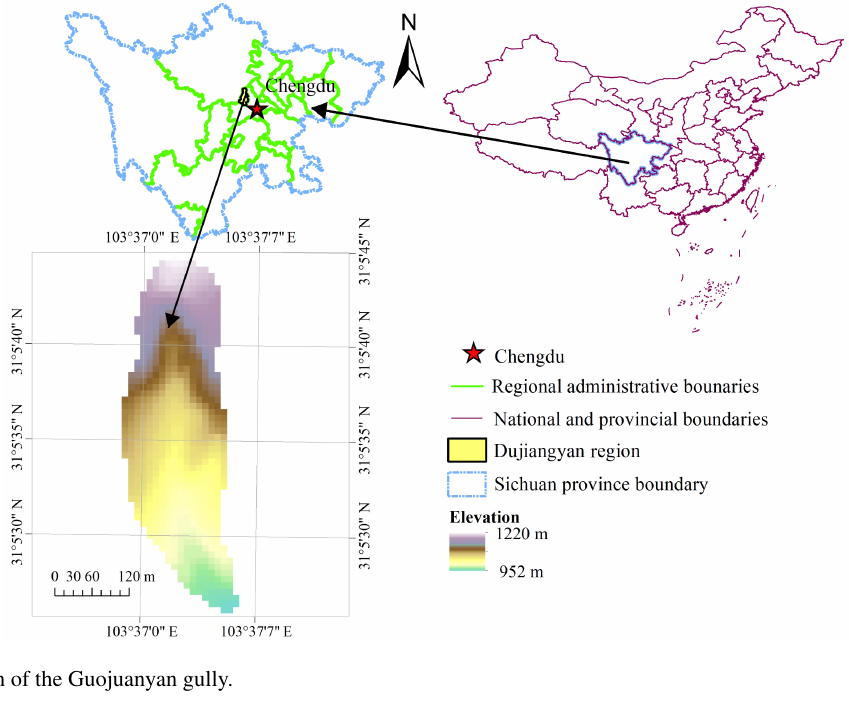
Figure 1. The location of the Guojuanyan gully.